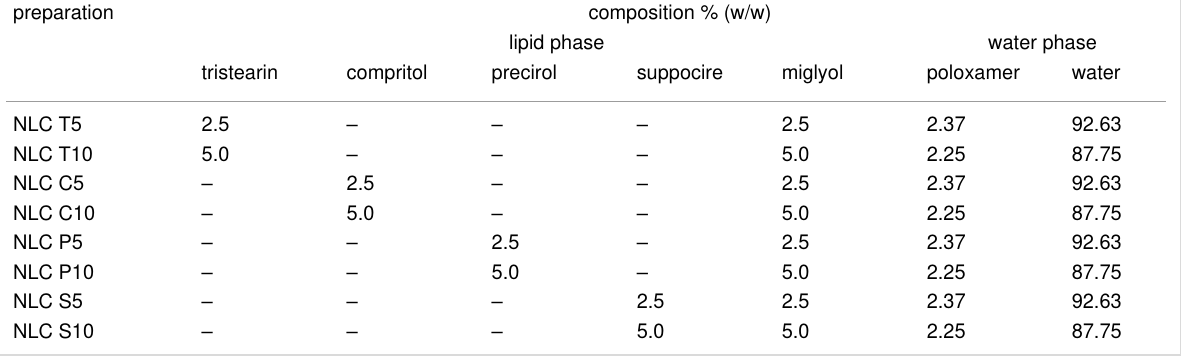
Table 2: Composition of nanostructured lipid carriers